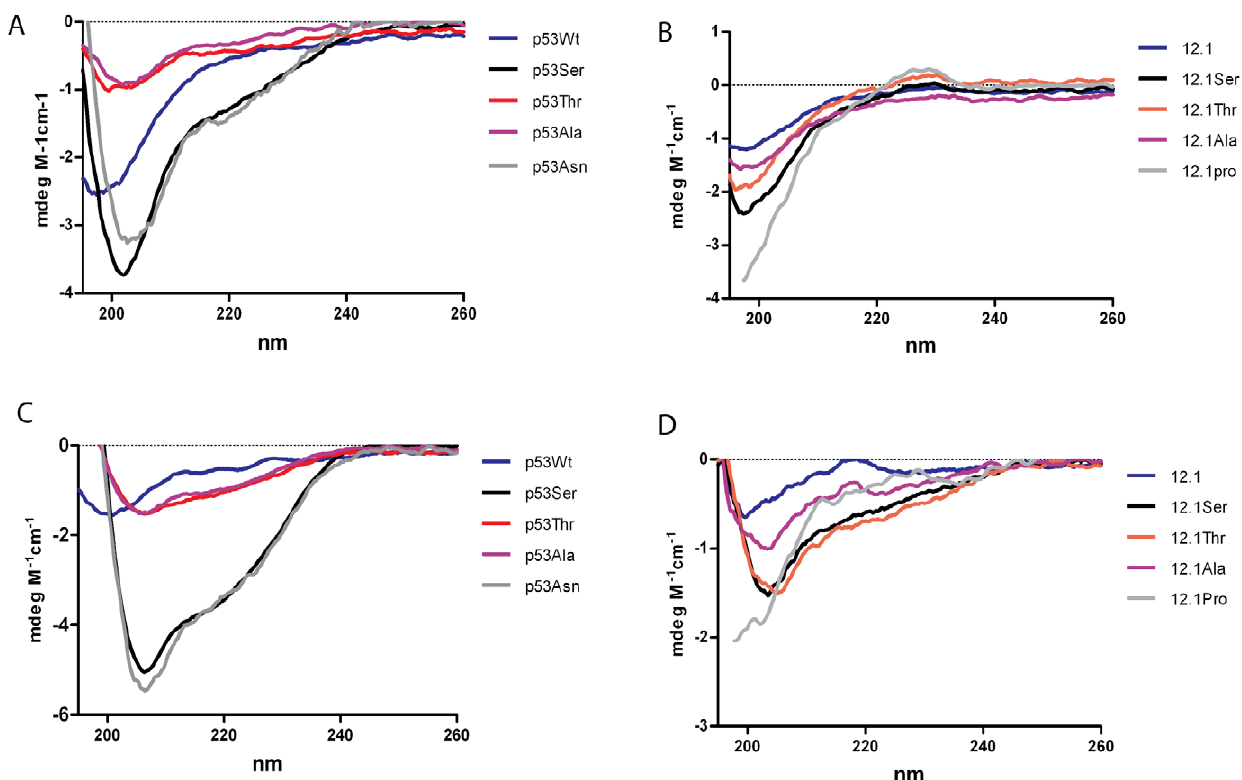
Figure 2. CD spectra of MDM2 interacting peptides free in solution. (A) CD spectra of the peptides P53Ser, p53Thr, p53Ala, p53ASN and p53WT in 5 mM Sodium Phosphate buffer pH 7.0 (C) and with the addition of 30% TFE. (B) CD spectra of peptides 12/1Ser, 12/1Thr, 12/1Ala, 12/1Asn and 12/1 in in 5 mM Sodium Phosphate buffer pH 7.0 and (D) with the addition of 30% TFE.